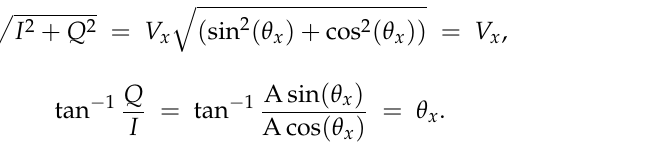
Figure 11. Functional block diagram of algorithm for uniaxial digital orthogonal phase-locked